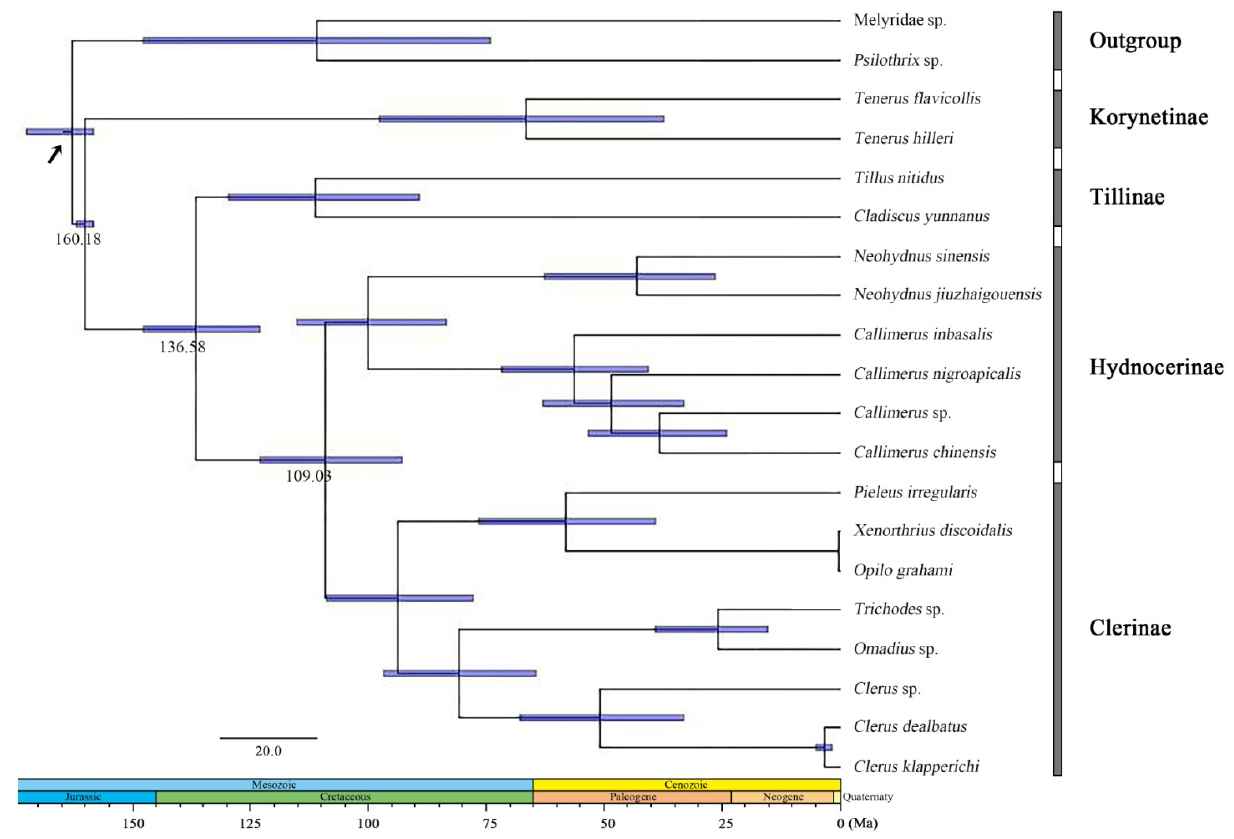
Figure 3. Chronogram with estimated divergence time based on fixed rate calibration amongst Cleridae using BEAST1.10.4. Horizontal bars represent 95% credibility intervals of time estimates. Numbers on the nodes indicate the mean divergence times. Calibration point is marked by an arrow.